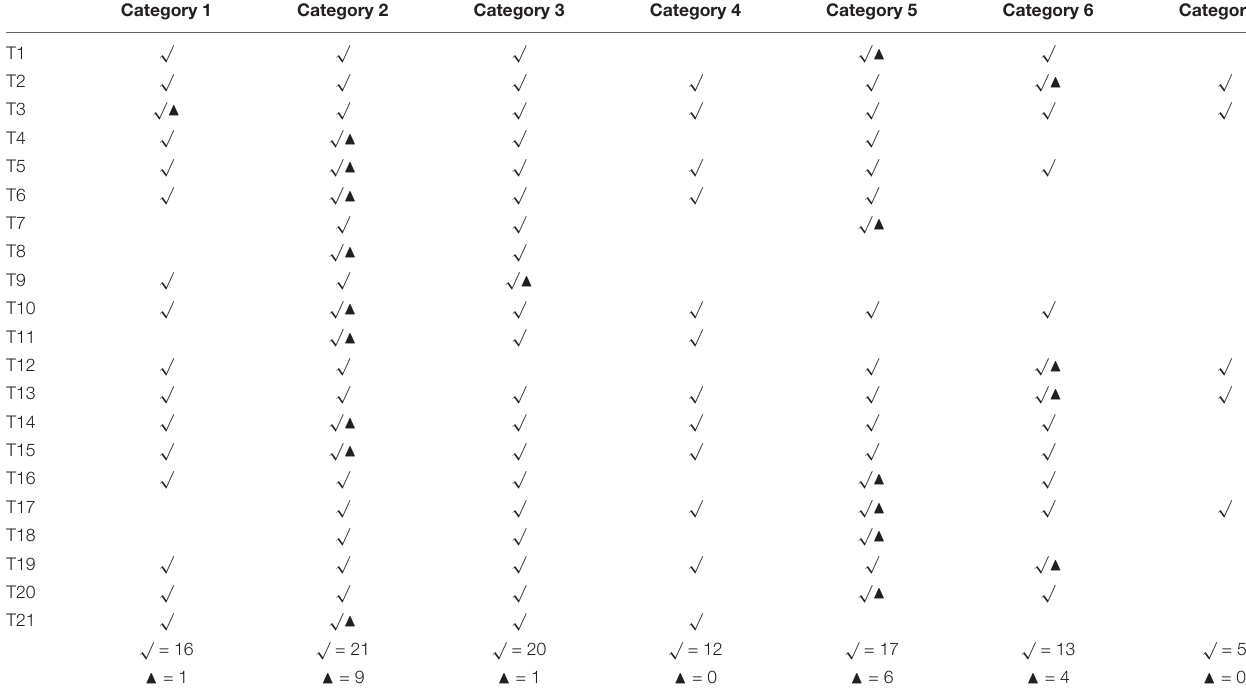
TABLE 4 | Frequency distribution of teachers’ conceptions of